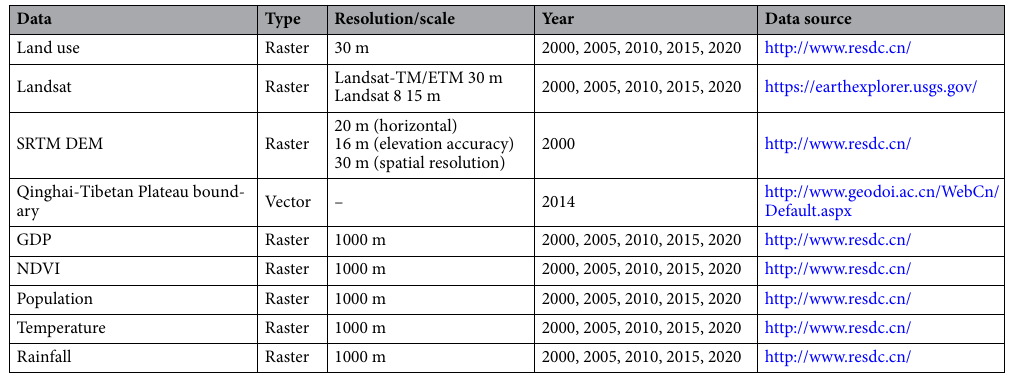
Table 1. Characteristics of data used for the